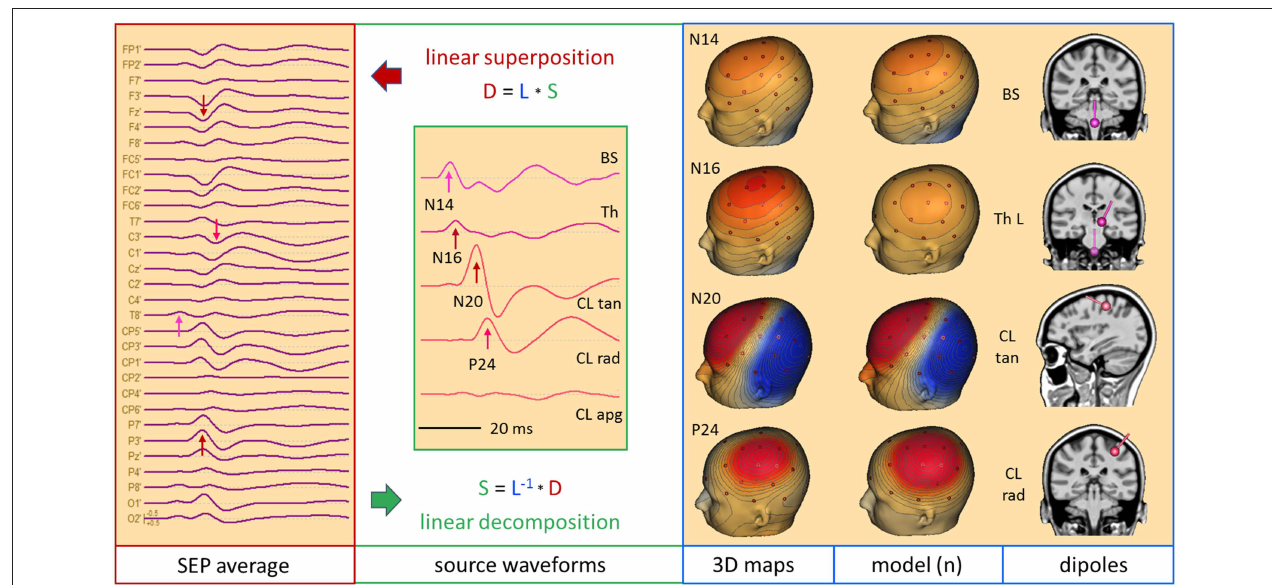
FIGURE 8 | Right median-nerve SEP recorded with 31 channels and high SNR. The distance between scalp traces corresponds to 2 µ V and transforms into 30 nAm between source waveforms. Filter settings: 20Hz forward to 200Hz. Scalp waveforms show negative up and source waveforms the current flow into the direction of the dipole vector (right). The dipole model consists of a vertical source in the brainstem (BS), an oblique source in left thalamus (Th L) and a regional source (CL) in the contralateral left central hand area ( 22, 23). The regional source has been rotated to separate the near-to-tangential N20 component (CL tan) from the radial P24 (CL rad). The linear inverse L − 1 is based on the model topographies of the 5 dipoles shown in column model (n). They are quite similar to the 3D maps at the peaks of N14, N20, and P24. At N16, there is still considerable overlap from N14. L − 1 reduces the 31 scalp signals to 5 source waveforms showing the separation of the underlying components N14, N16, N20, and P24, labeled by their first peaks. The 3rd dipole of the regional source CL is oriented along the postcentral gyrus (CL apg). Its flat source waveform confirms that (a) no evoked current is flowing along the gyrus, (b) N20 and P24 components fully model the activity of CL, and (c) the model consisting of the preceding 4 dipoles is sufficient to explain and decompose the